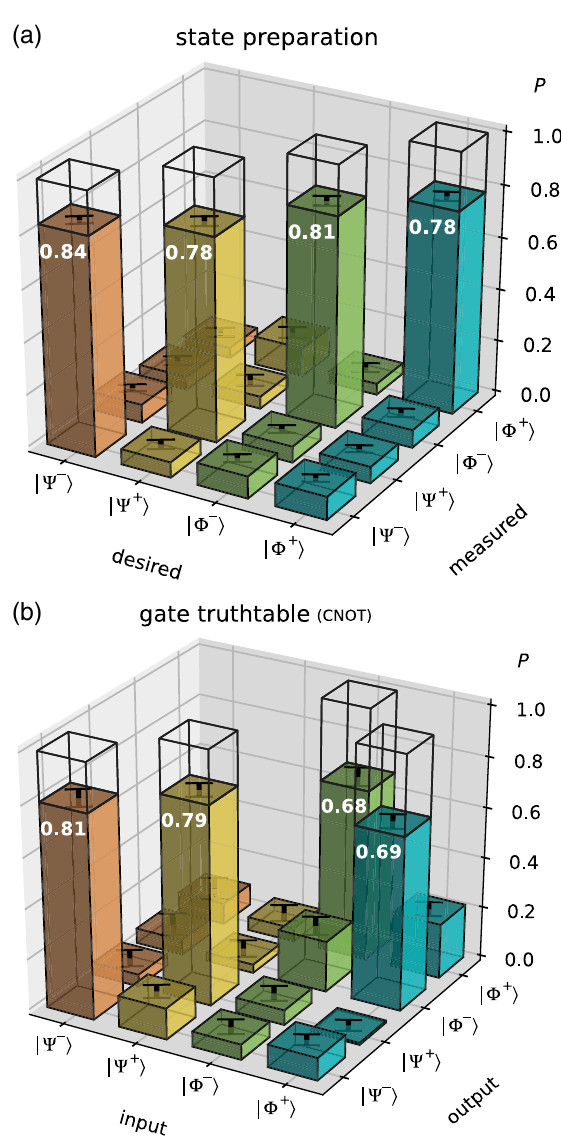
FIG. 3. Fidelities of the experimentally generated states in the Bell basis. (a) Bar diagram of the fidelities of the four Bell states used as an input for our gate. (b) Measured fidelities of the two- atom states resulting from the gate operation on these input states. Error bars are statistical standard deviations of the mean. The truth tables for ideal input states and gate operations are shown as transparent bars for